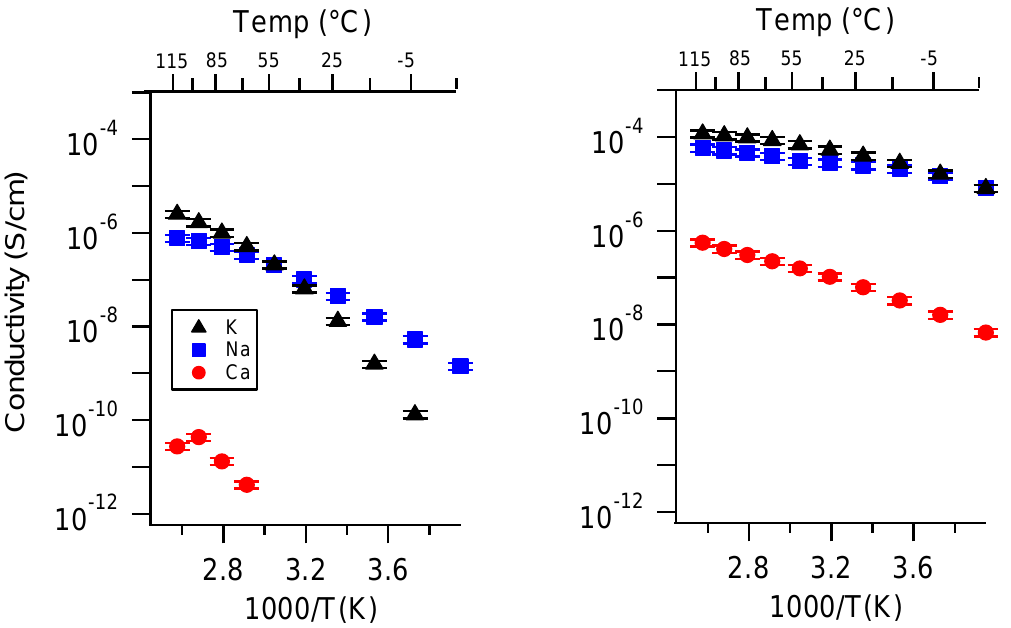
Figure A3. Conductivity as a function of cation for PEGDMA1000_high_SSM (left) and PTHFDA1000_high_STFSI (right) SIPEs swelled with DEG. Temperatures ranged from − 20 °C to 115 °C.